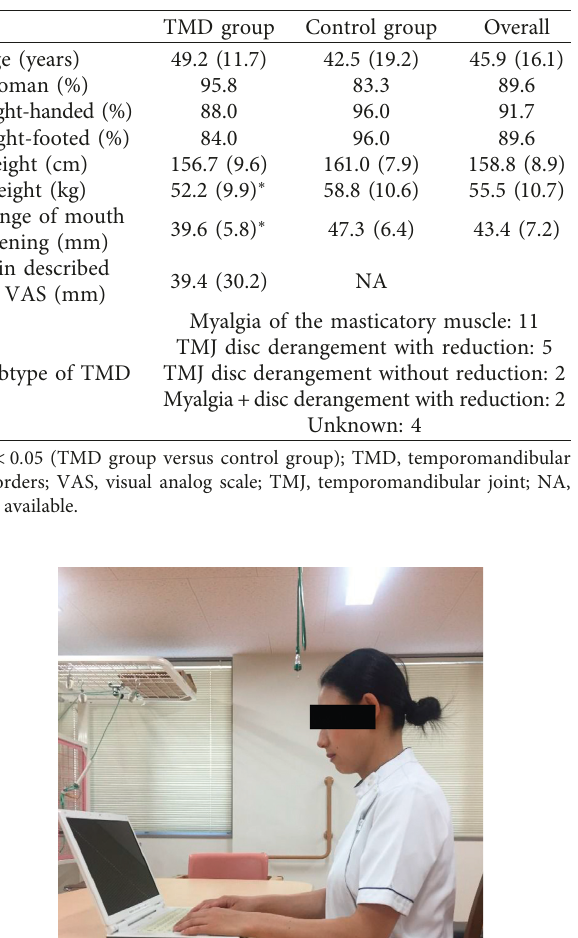
Table 1: Characteristics of the